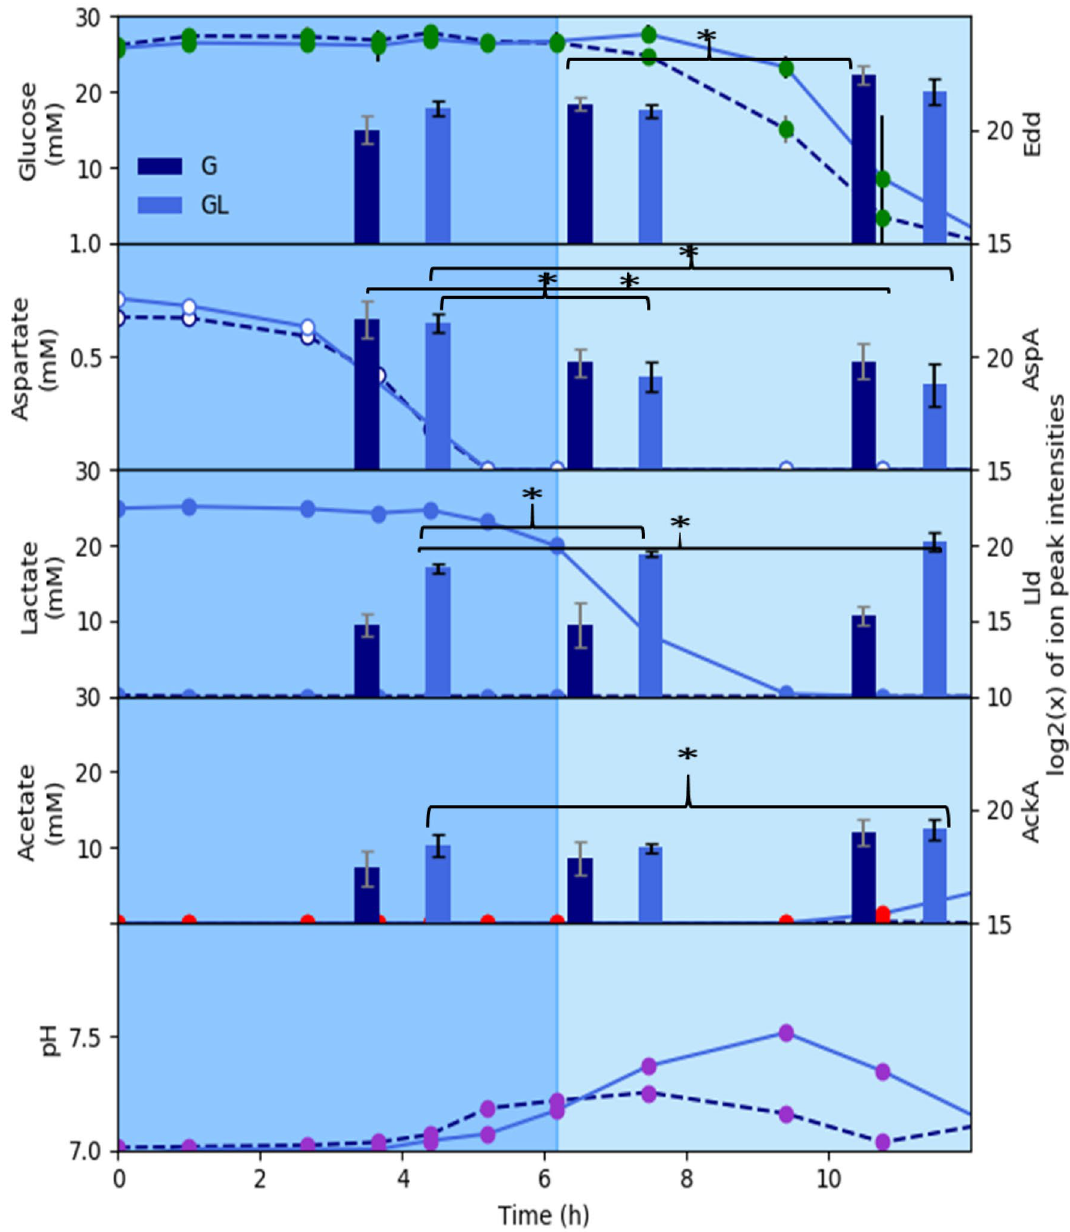
Figure 4. Substrate-specific, protein abundances for P. aeruginosa 215 cultures grown on chemically-defined CSP G (dark blue bars and dashed lines) and CSP GL (light blue bars and solid lines) media which contain glucose and glucose + lactate, respectively. Substrate concentrations for each enzyme are plotted in the same panel to highlight relationships. The three bars represent batch growth time points 4, 7, and 11 h. Metabolite values are averaged from three biological replicates and two technical replicates. Protein values are averaged from three biological replicates. * p value < 0.05; ** p value <